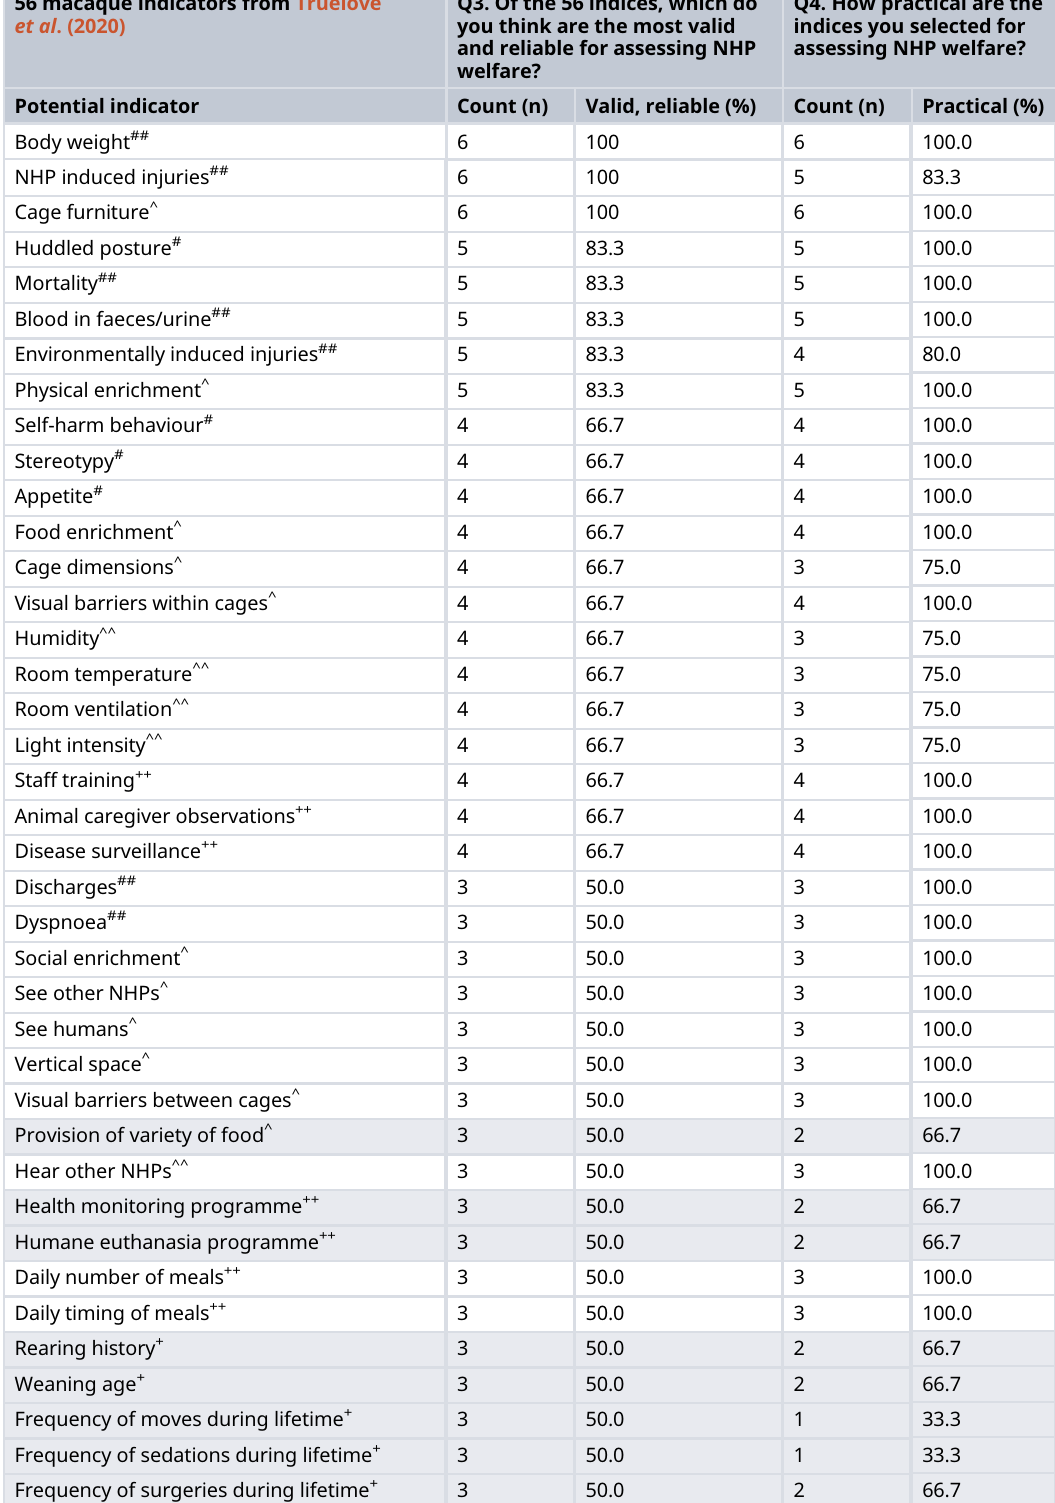
Table 5. Ranking of validity and reliability and practicability scores for marmosets, 56 indies (n=6 respondents). 56 macaque indicators from Truelove et al . (2020)